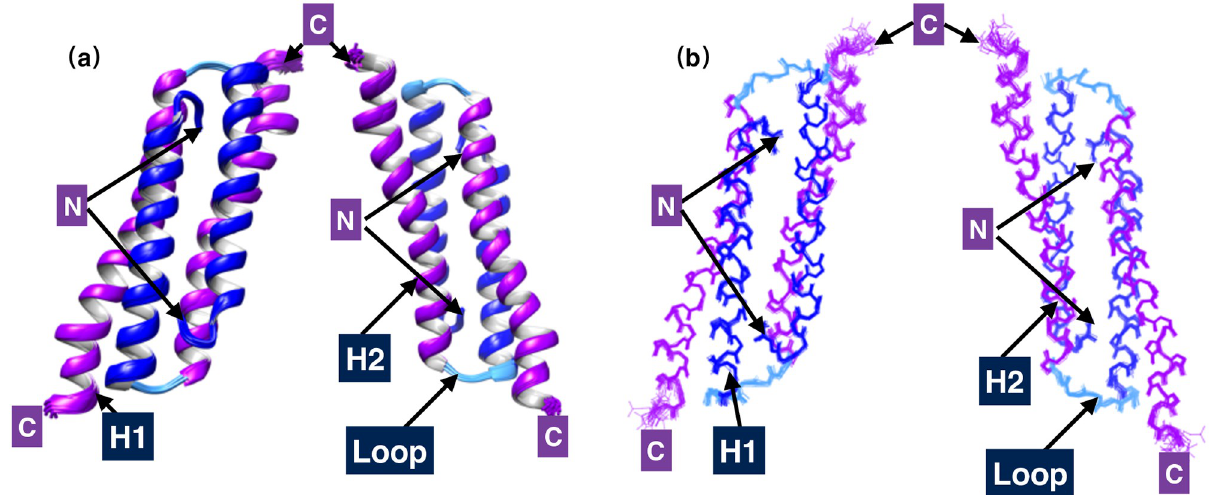
Fig 2. Solution structures of PRC1-DD. (a) Ribbon representation of the 20 lowest-energy structures. (b) Backbone chain trace of the 20 lowest- energy structures; helices H1 and H2 from the two monomeric units in the homodimer are colored separately in blue (H1, M1-E28), cyan (loop, I29-D32) and purple (H2, E34-L65); C and N tags signify C- and N-terminal ends, respectively. This and all other structural figures were generated using the program CHIMERA.